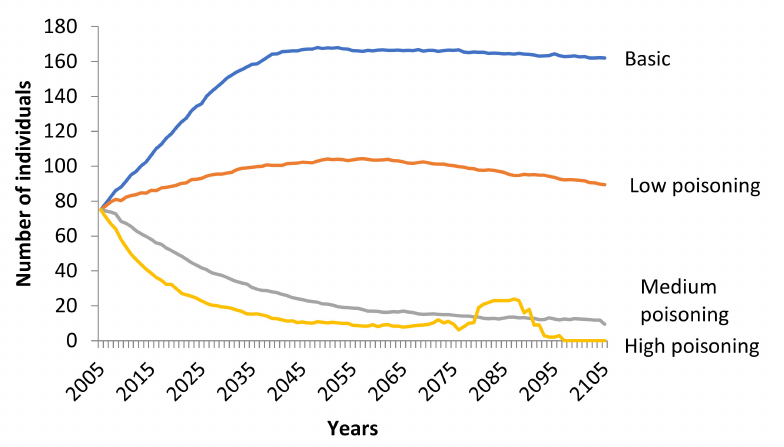
Figure 3. Trend of the Eurasian Black Vulture ( Aegypius monachus ) population, under low, medium, and high poisoning scenarios simulated (100 years) in Southeast Europe. Poisoning inserted as a catastrophic event with frequency of occurrence 20%. The effect on fecundity was set at 0.90 (10% decrease) and the effect on survival was set at 0.90 (10% decrease), 0.70 (30% decrease) and 0.50 (50% decrease) for low, medium, and high poisoning, respectively. All other parameters remained stable as in the basic scenario.